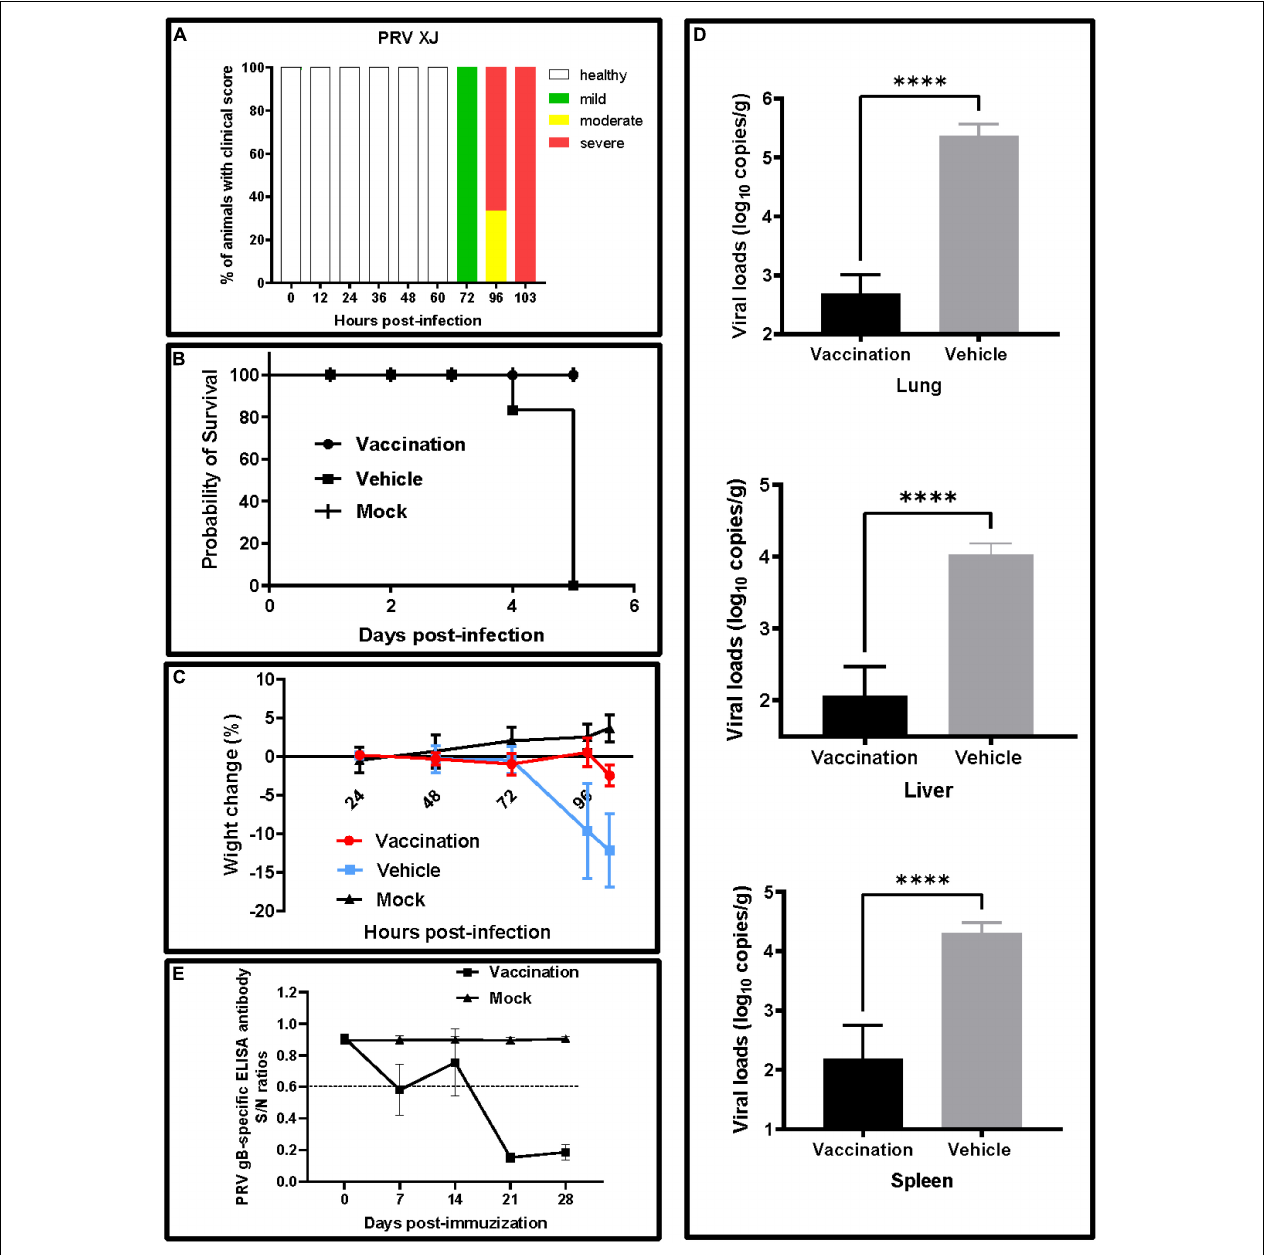
FIGURE 2 | Clinical signs and viral loads of experimental mice. (A) Clinical score. The frequency of sick animals infected with pseudorabies virus (PRV) XJ. Based on a scoring system ( Supplementary Table 1 ), the animals were categorized into either healthy (white) and mildly (green), moderately (yellow), or severely affected (red). (B) Survival curves for mice after a virulent challenge with PRV XJ. The survival percentages were presented as a Kaplan–Meier plot ( n = 6 per group). (C) Weight change of mice in each group after immunization and challenge. (D) The viral DNA loads in the lung, liver, and spleen were determined by qRT-PCR. The viral DNA copy numbers were measured with specific primers for the gE gene. (E) Development of PRV gB-specific antibody. **** p < 0.0001.